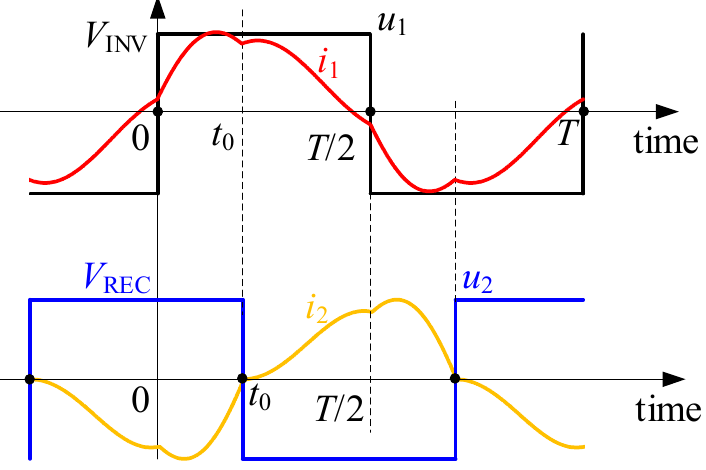
Figure 4. Typical waveforms of inverter and rectifier ac voltages and currents. When t 0 < t < T /2, S 2 , S 3 , S 5 , and S 8 are all on, namely u 1 is positive and u 2 is negative, the differential equations can be given as